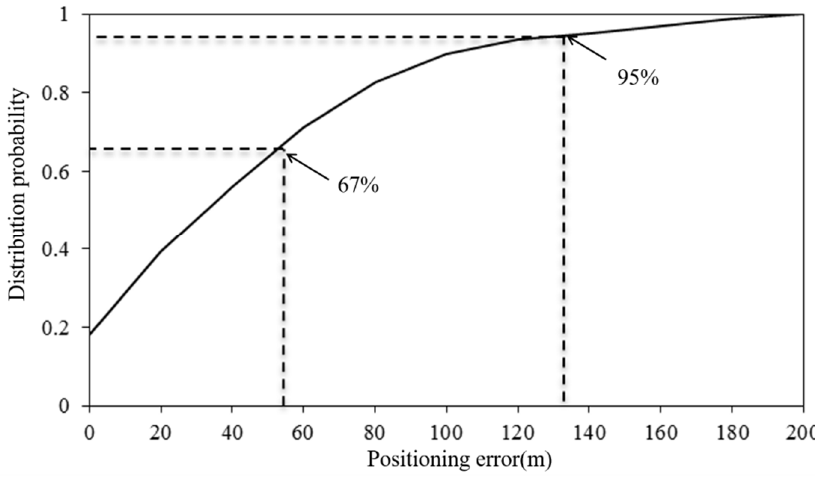
Figure 9. WFB cumulative distribution probability.